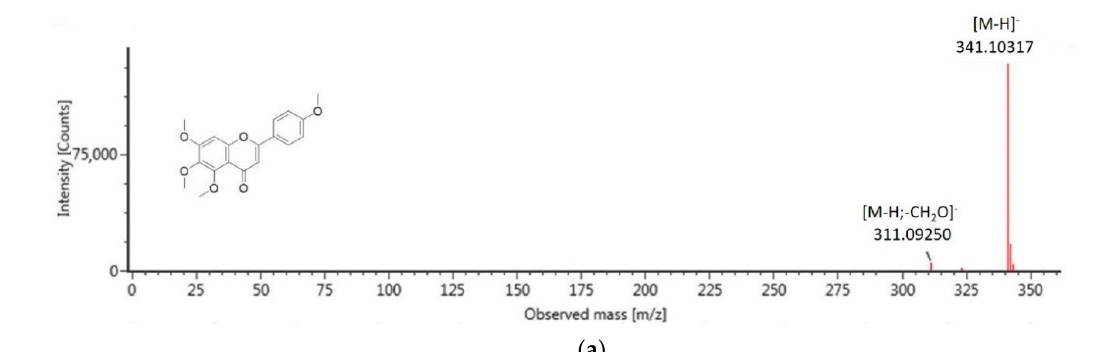
Molecules 2020 , 25 , x FOR PEER